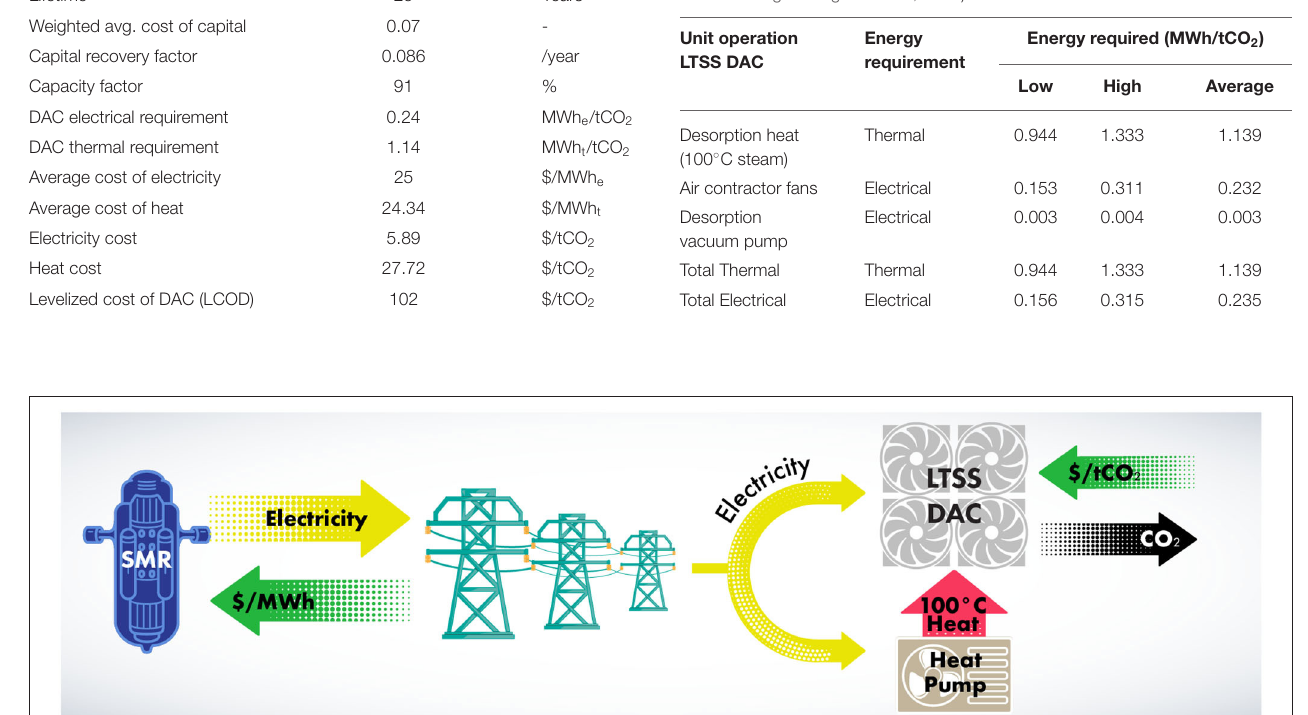
TABLE 2 | Energy requirements for LTSS DAC systems (National Academies of Sciences Engineering Medicine, 2019 ).